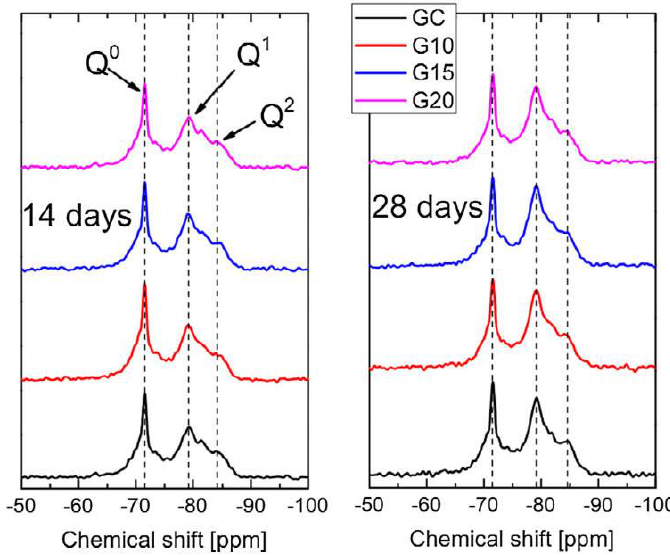
Figure 17. 29 Si-NMR spectra of GO/cement composite specimens at 14 and 28 days. Reprinted with permission from Ref. [99]. Copyright 2017 Elsevier.